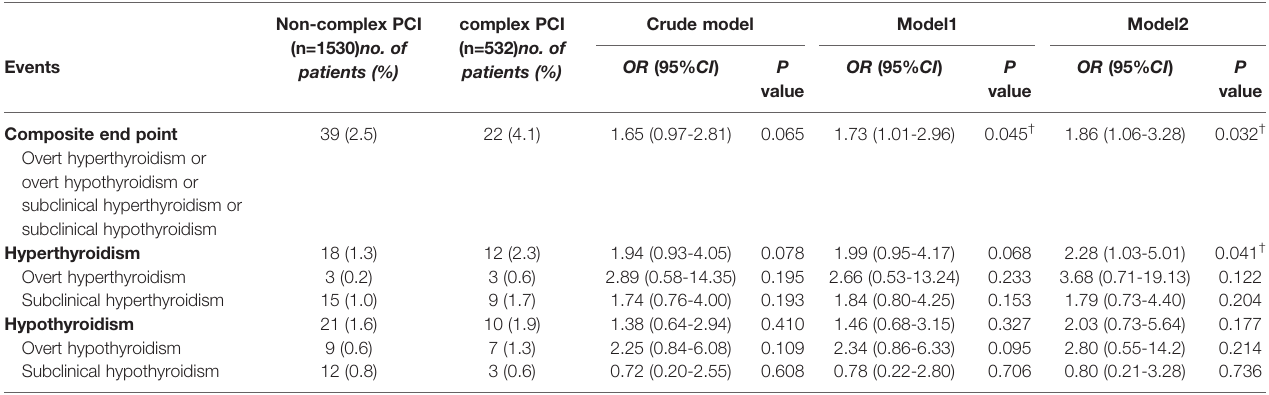
TABLE 4 | Subgroup analysis based on non-complex PCI and complex PCI population for 1-year clinical outcomes. Non-complex PCI (n=1530) no.